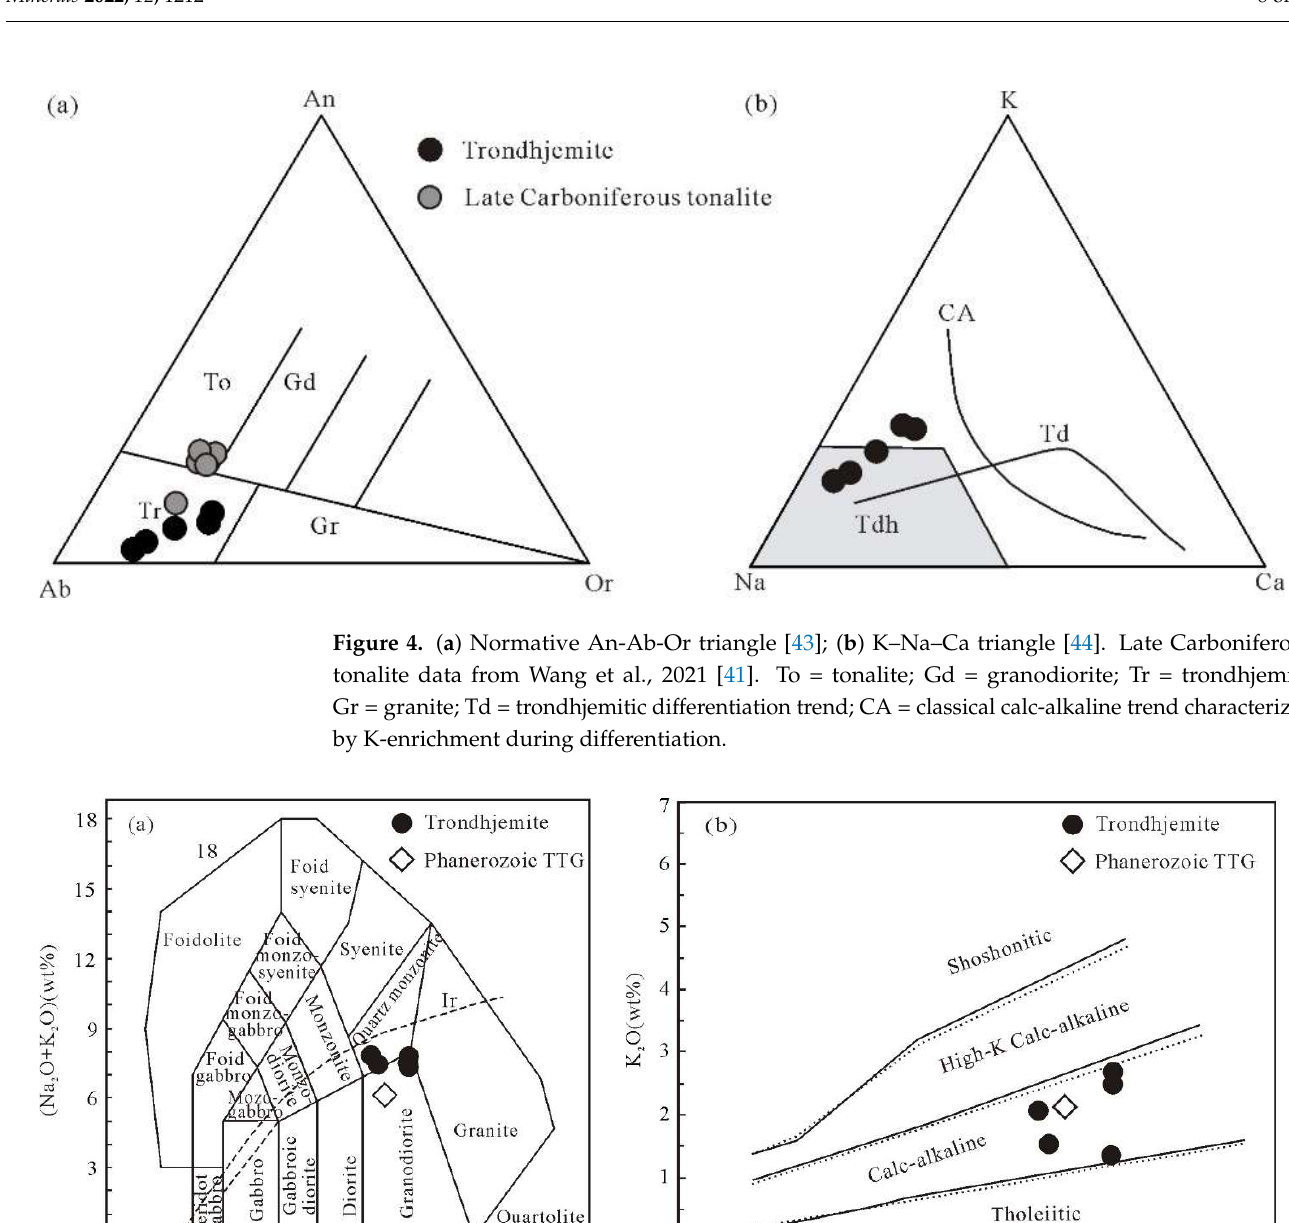
0.99 a All oxide contents in the samples were recalculated to 100% on a volatile-free basis; b total before normalization. T Fe 2 O 3 as total Fe 2 O 3 . (La/Yb) N is ratio of La and Yb normalized by chondrite. Mg # = 100× [Molar Mg/(Mg+Fe 2+ )]. Phanerozoic TTG data from Condie [6]. TTG rock data in the Central Asian Orogenic Belt from [35,36,40]; Late Carboniferous tonalite data from Wang et al., 2021 [41]. The samples had low total rare-earth element (REE) contents (30.58–77.80 ppm) and showed light rare-earth element (LREE) enrichment and heavy rare-earth element (HREE) depletion in the chondrite-normalized REE diagrams ([La/Yb] N = 5.76–10.52) with no pro- nounced Eu anomaly (Eu/Eu* = 0.89–1.00; average = 0.96) (Figure 6a). The striking chemi- cal characteristics were the high contents of Sr (286–601 ppm; average = 465 ppm) and low contents of Y (7.12–11.10 ppm; average = 8.66 ppm) and Yb (0.81–1.16 ppm; average = 0.91